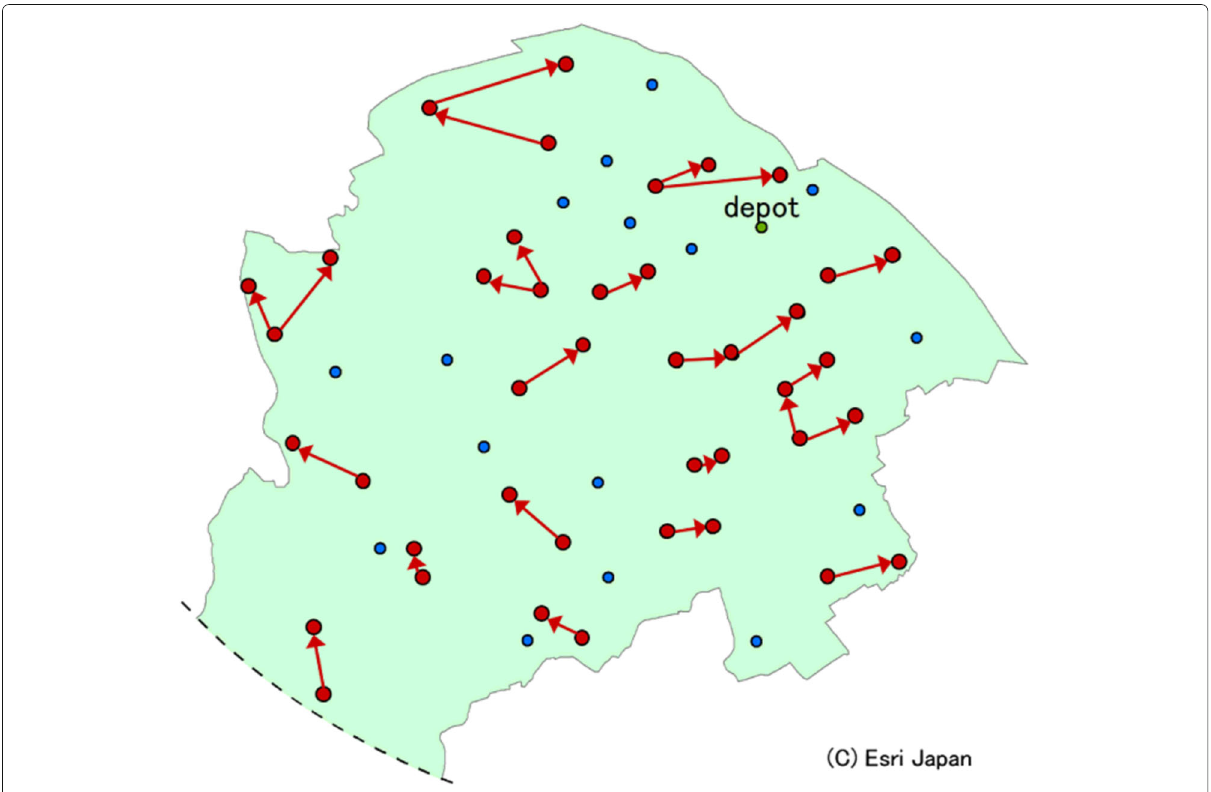
Fig. 8 Hasse diagram of ( V , ≺ )